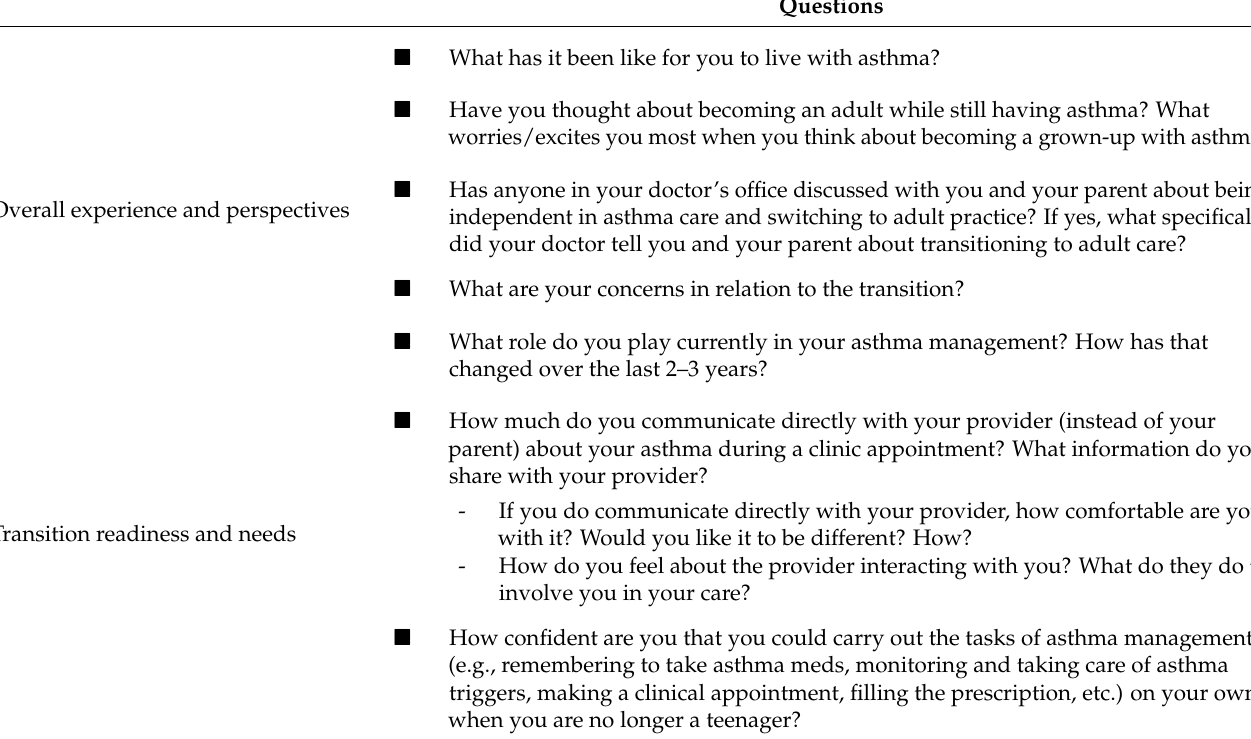
Table 1. Semi-structured interview